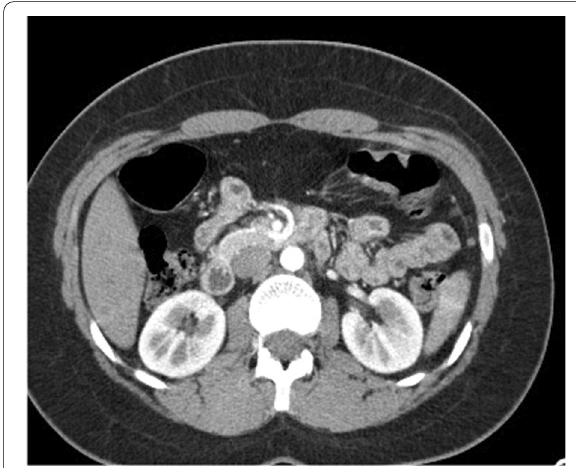
Fig. 1 CECT shows jejunal branches originating from the posterior border of the superior mesenteric artery at the point of 3rd part duodenal crossing with relative space narrowing between it and the aorta